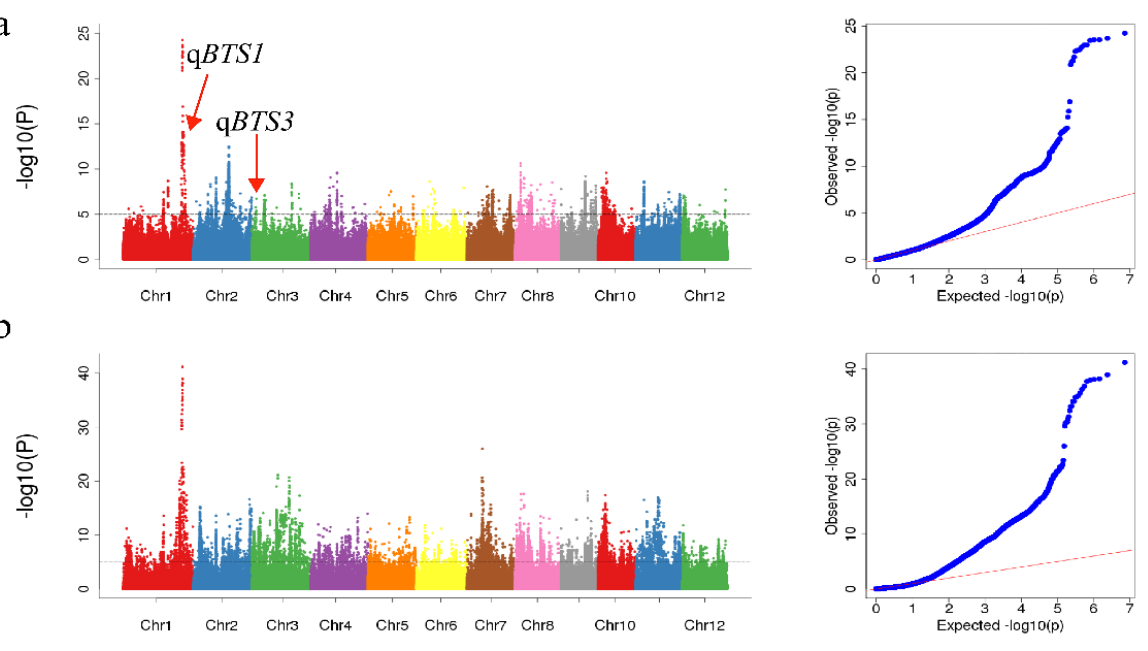
Figure 2. Manhattan and quantile–quantile (QQ) plots for rice seed shattering: ( a ) 2021 early season. ( b ) 2020 late season. The red lines represent the significant −log10( p value) ( p = 1.0 × 10 −5 ).